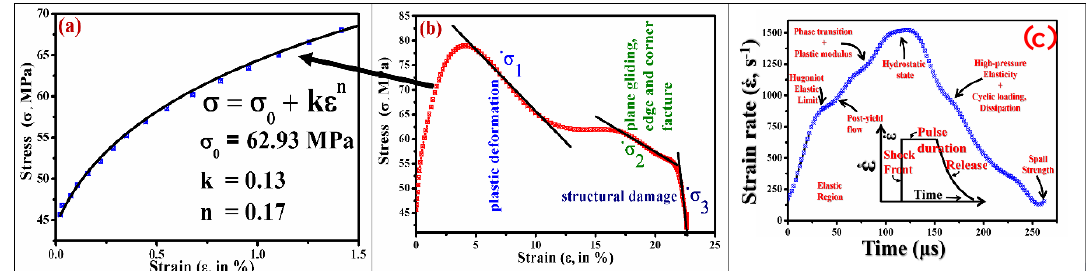
Figure 2. ( a ) Magnified region of stress, σ , (MPa) vs. percentage strain, ε , the curve (arrow: elastic region) tangent shows the estimated strain-hardening time parameter, ( b ) corresponding plastic regime showing variations in stress rate, 𝜎̇ 𝑖 , three stages (shown by slope lines) of dynamic deformation in GLNR, and ( c ) variations in strain rate, ἑ , with time, imprinting a specific shock wave profile onto 2D GLNR exhibiting a number of stages.